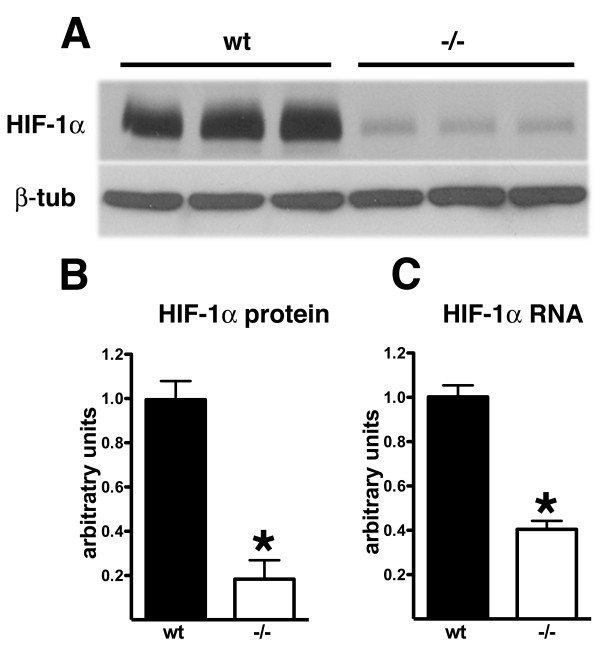
Basal levels of HIF-1α are decreased in Psen1-/- fibroblasts. Shown are prolonged exposures of Western blots from non-stimulated Psen1+/+ and Psen1-/- fibroblasts. A representative experiment that was performed multiple times is shown in panel A. In panel B, the experiment in (A) is quantified (asterisk indicates p = 0.0005, unpaired t-test). In panel C, levels of HIF-1α RNA were determined in Psen1 +/+ and Psen1-/- fibroblasts by qPCR (n = 3 cultures per group). Samples were run in triplicate and normalized to the geometric mean of Ppia and Gusb. Asterisk (*) indicates p = 0.0008.